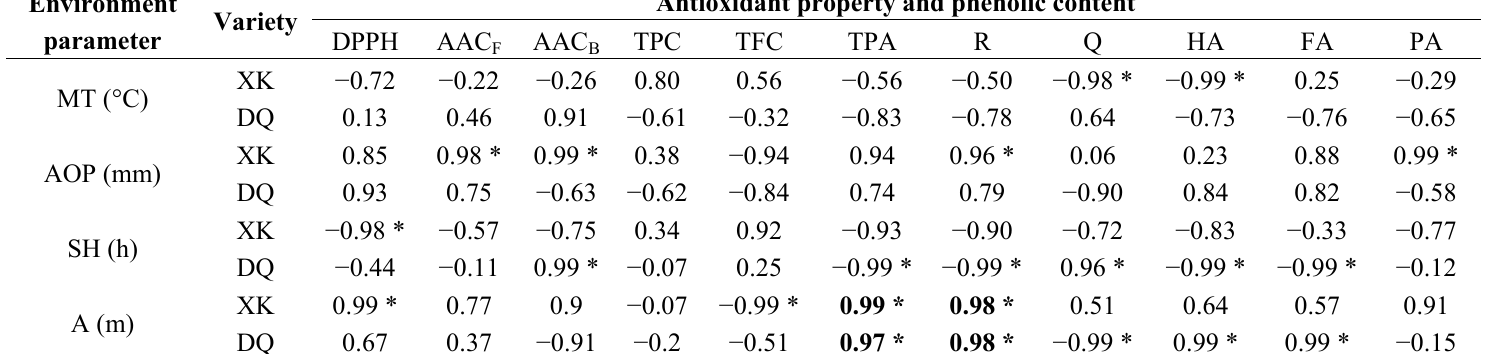
Table 4. Correlation analysis of growing conditions and antioxidant properties and phenolics for two tartary buckwheat varieties grown in 3